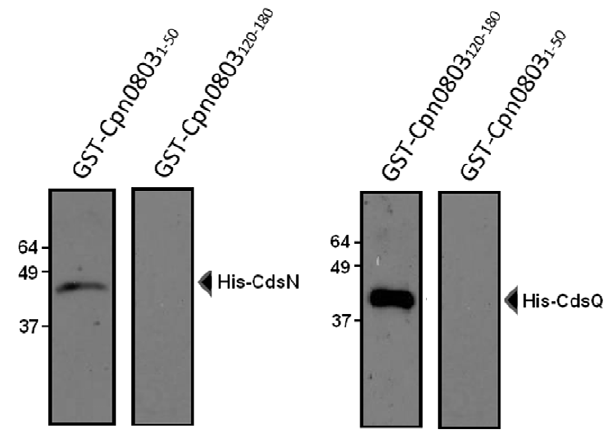
Figure 9. Corroboration of the Cpn0803 binding regions identified by Pepscan using GST pull-downs. To corroborate the Pepscan results, we expressed 50 amino acid fragments of Cpn0803 encompassing the CdsN and CdsQ binding domains and performed GST pull-down assays against recombinant CdsN or CdsQ. GST-